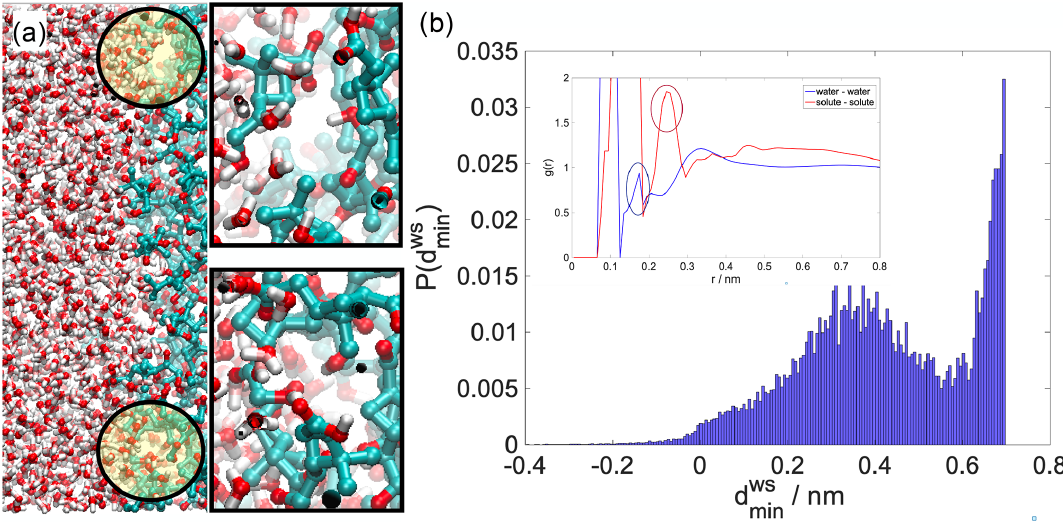
Figure A3. (a) Equilibrium snapshot of the water–organic interface with examples of voids enlarged. The probability distribution of the minimum local distance between the maximum of the aqueous phase and the minimum of the organic phase at the interface in the absence of the pulled molecule. For comparison in the inset we show bulk radial distribution functions whose first intermolecular peaks (circled) can give an estimate of the mean distances in the bulk phases.